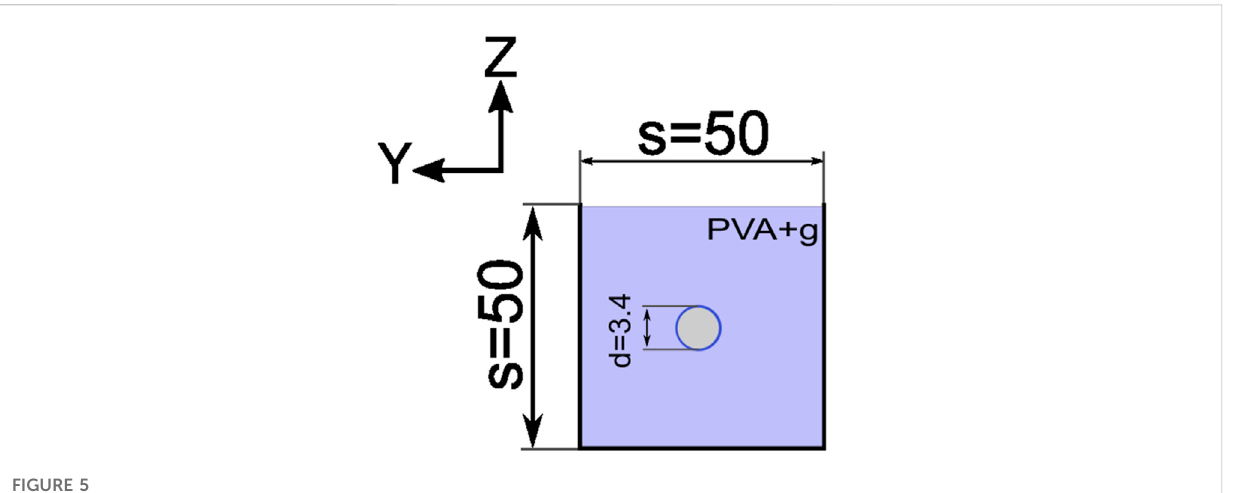
FIGURE 5 An image of the gypsum plate in the study.